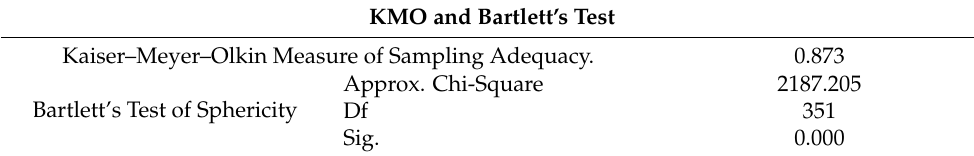
Table 3. The results of KMO and Bartlett’s Test.